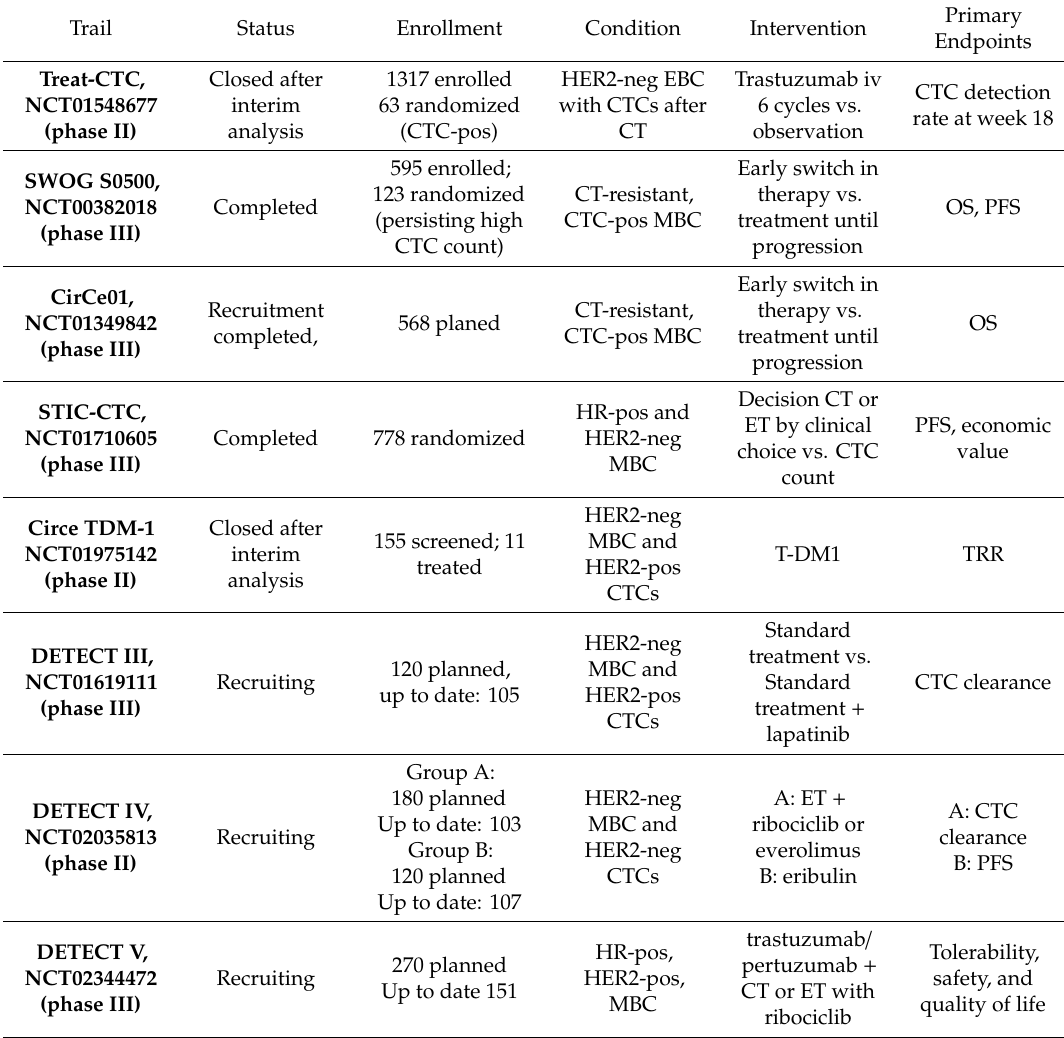
Table 1. Clinical trials with CTC-based treatment